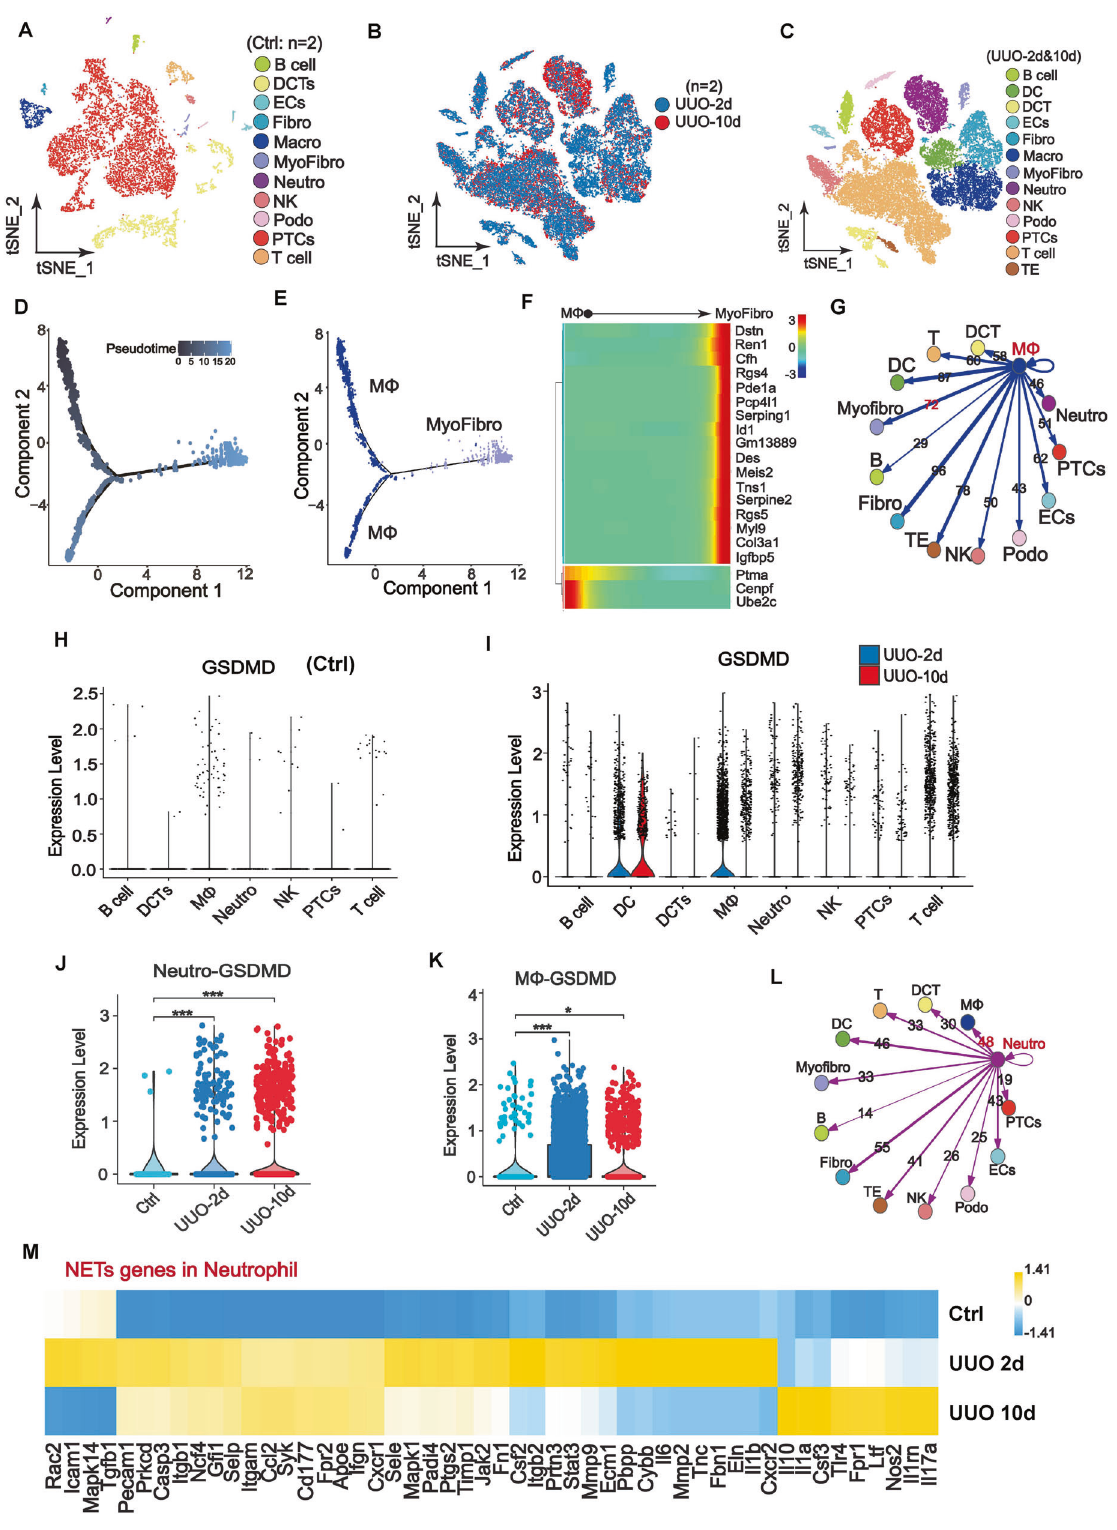
Speci fi c deletion of Gsdmd in neutrophils instead of macrophages protected the kidney from undergoing fi brosis after UUO To distinguish the speci fi c contribution of each in fl ammatory cell type to prevent fi brosis in the Gsdmd − / − mouse, we generated Cell Death and Disease (2022)